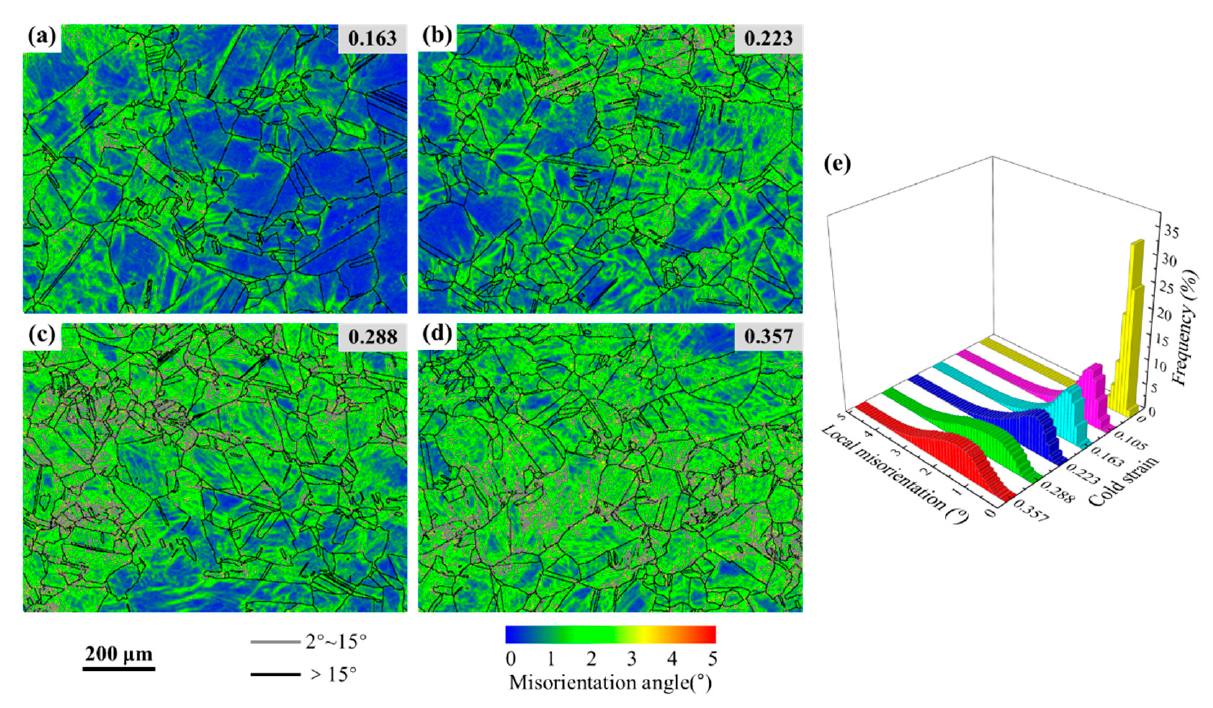
Figure 6. KAM maps ( a – d ) and local intragranular misorientation distributions ( e ) of the specimens cold compressed to different strains of 0.163, 0.223, 0.288, and 0.357.